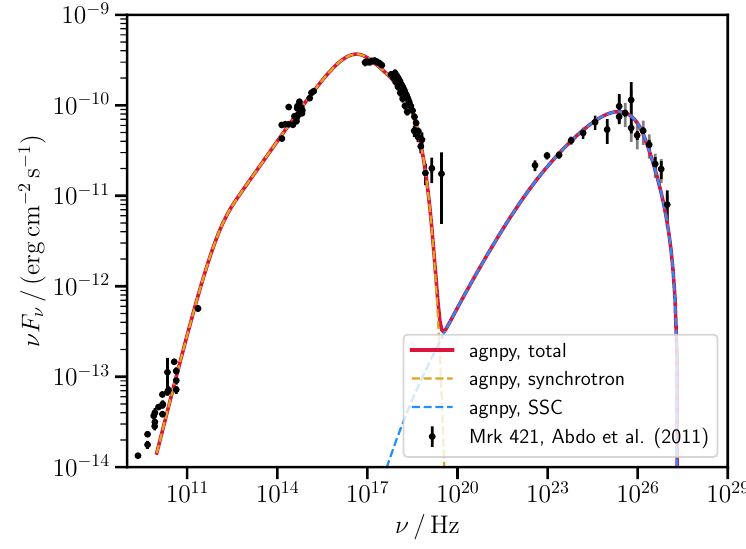
Figure 6. γγ opacity for absorption on the BLR photon field computed with agnpy. Left panel : Validation of agnpy result against the literature for a small viewing angle ( θ s = 0 ◦ , blazar case). Right panel : Internal cross-check approximating, for large distances from the BH, the BLR as a monochromatic point source at the BH position. A non-null viewing angle is considered in this case ( θ s = 20 ◦ , radio-loud AGN case). Figure from [78], reproduced with permission of Astronomy and Astrophysics.